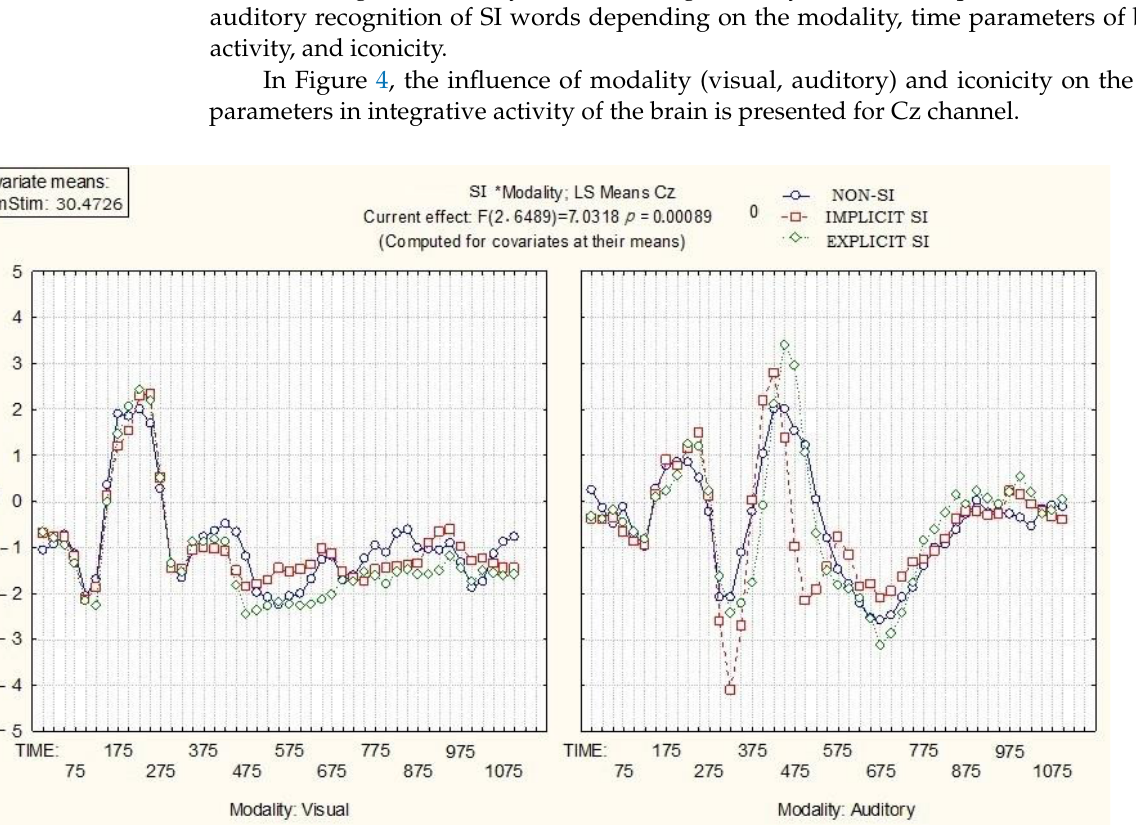
Figure 4. Differences between three groups of stimuli (explicit and implicit SI words and non - SI words) in both modalities (visual and auditory) for Cz channel. '*' is a multiplication